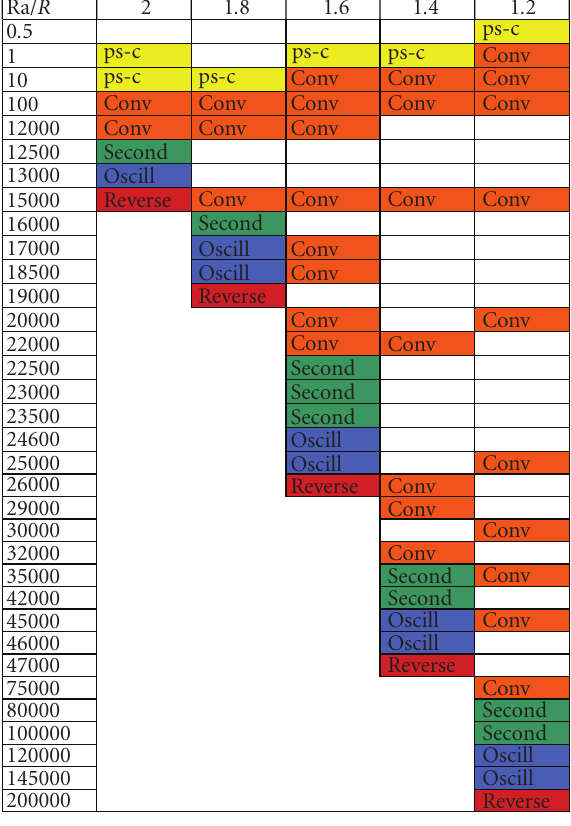
Figure 2: Map of the various regimes: pseudoconductive (ps- c ), convective ( conv ), secondary motion ( second ), oscillatory ( oscill ), and chaotic ( reverse )